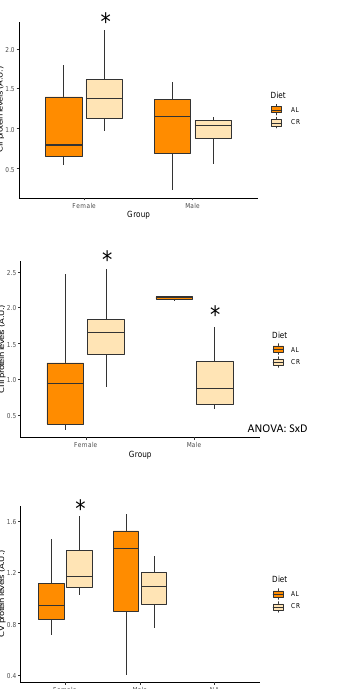
Figure 2. Effects of calorie restriction on oxidative phosphorylation (OXPHOS) complexes. Boxplots showing the protein expression levels of Complex II, Complex III, and Complex V and representative bands of the Western blot. Two-way ANOVA was performed to assess for significance. Abbreviations: SxD, interactive effect between sex and diet; D, diet differences; NS, non-significant; AL: ad libitum; CR: caloric restriction; F: female; M: male. * Significant difference between calorie-restricted and control group. Table 2. Protein levels of OXPHOS complexes and mitochondrial fission proteins analyzed by Western Blot. Two-way ANOVA was performed to assess for significance. Abbreviations: S, sex differences; D, diet differences; N, non-significant. * Statistical differences between calorie restricted and control groups. Female 0.17